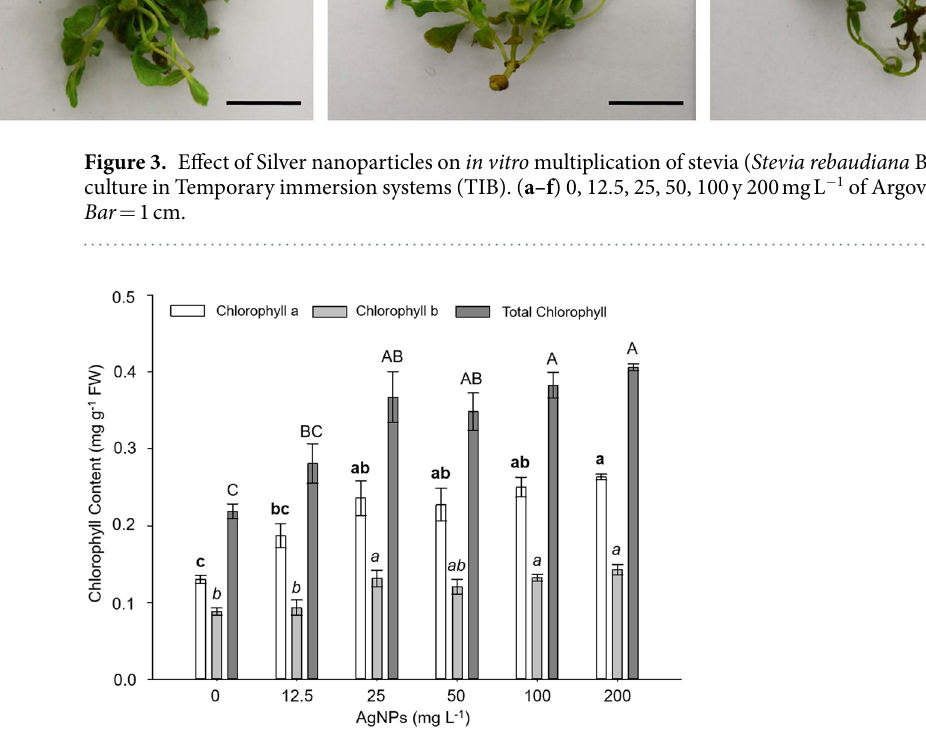
Figure 4. Chlorophyll content after stevia ( Stevia rebaudiana B.) exposure to different concentrations of Argovit. Mean ± standard error within a bar followed by the same letter are not significantly different according to Tukey’s test at ( P ≤